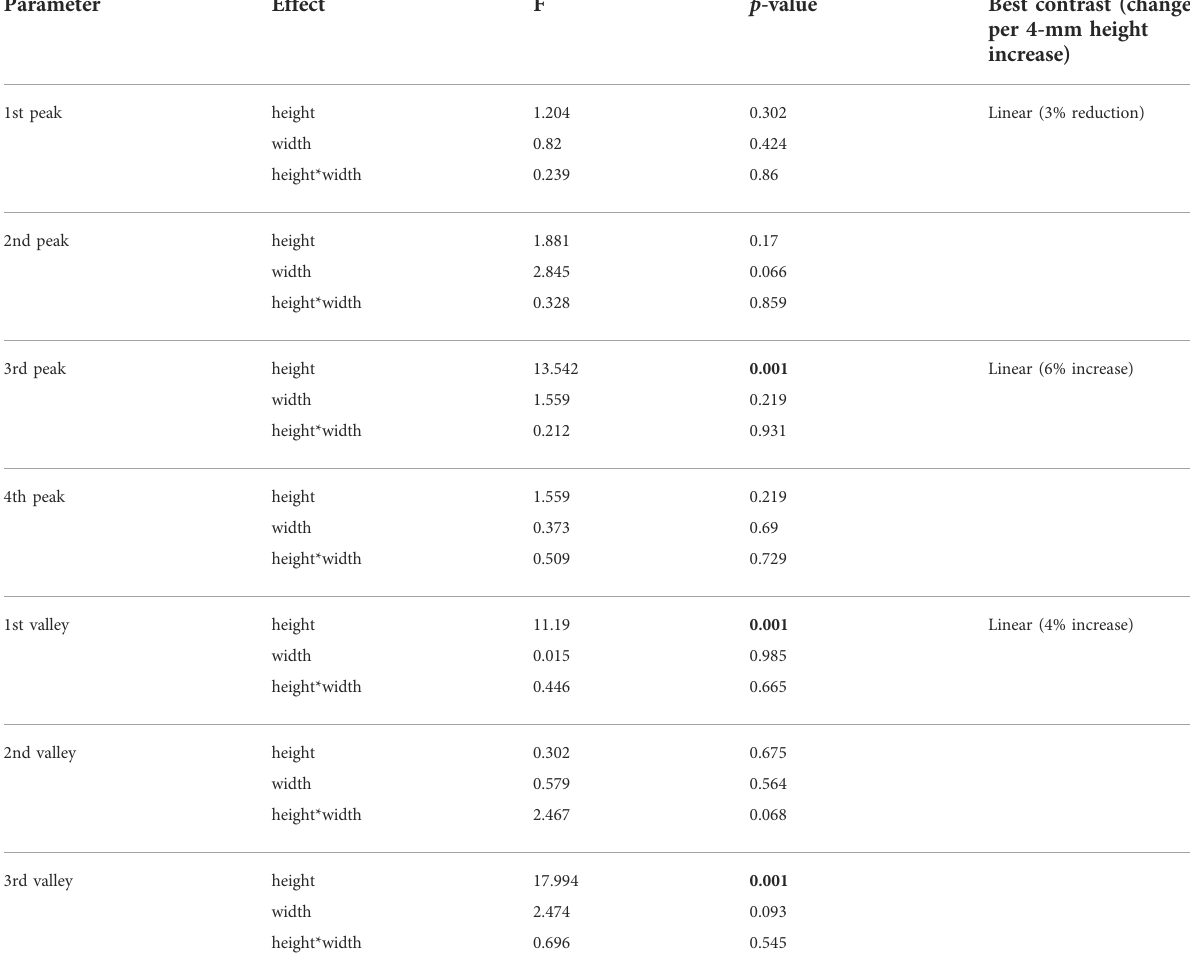
TABLE 1 Results of tests of within-subject effects from two-way repeated